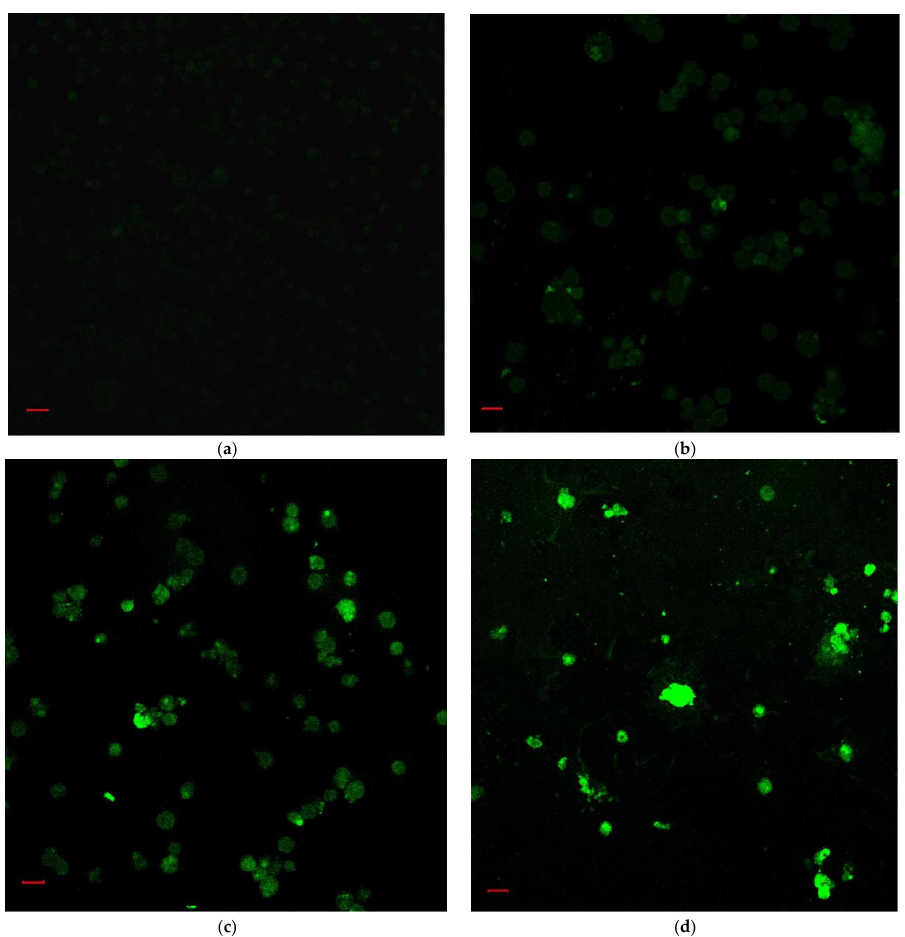
Figure 7. The apoptosis of LLC cells induced by rAj-Tspin was detected by TUNEL assay (Zeiss laser-scanning confocal microscopy, 200 × ). The bar indicates 20 µ m; ( a ) control; ( b ) 1.85 µ M rAj-Tspin; ( c ) 2.20 µ M rAj-Tspin; ( d ) 3.04 µ M